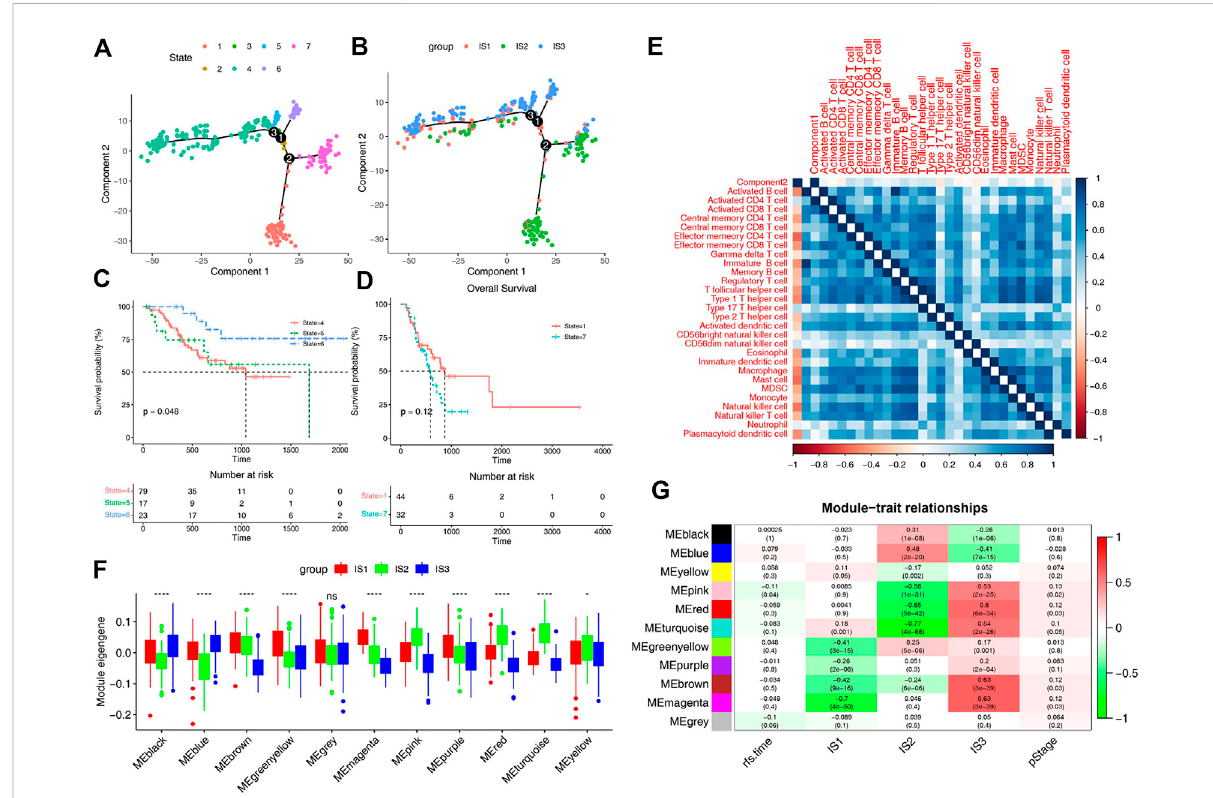
FIGURE 6 Immune landscape of STAD. (A) Immune landscape of STAD. Each point represents a patient and the immune subtypes are color-coded. The horizontal axis represents the fi rst principal component and the vertical axis represents the second principal component. (B) Immune landscape of the subsets of STAD immune subtypes. (C) Immune landscape of samples from three branches of IS3 and their prognostic status. (D) Immune landscape of samples from two branches of IS2 and their prognostic status. Differential enrichment scores of 28 immune cell signatures in the above subsets. (E) Heat map of two principal components with 28 immune cell signatures. (F) Differential distribution of feature vectors of each module in STAD subtypes. (G) Module-trait relationships of STAD immune